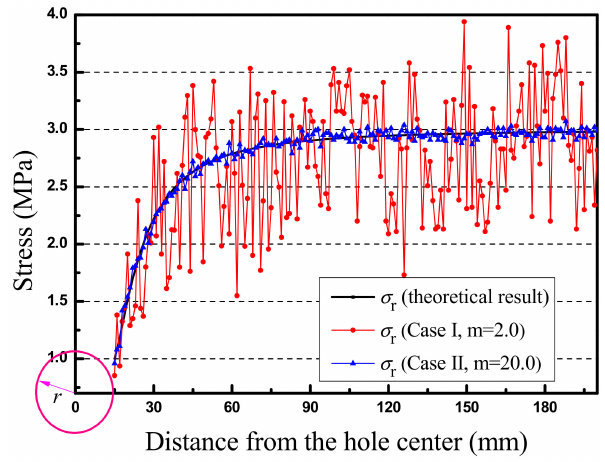
Figure 7. Stress distribution along the horizontal radius.